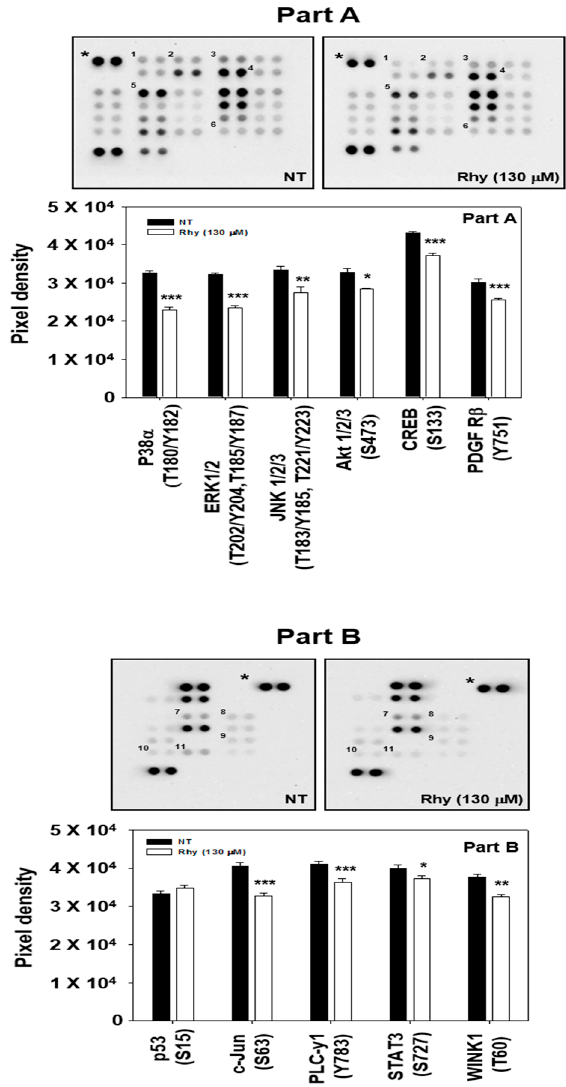
Figure 4. The Human Phospho-Kinase Array detects several phosphorylated proteins in Rhy-treated HepG2 cells. ( A , B ) HepG2 cells (1 × 10 7 cells/well) were incubated with Rhy (130 µM) for 12 h. Parts A and B of the array were each incubated with 330 µg of cell lysate. Arrays were performed according to the manufacturer’s protocols using Human Phospho-Kinase Array Kit (R&D Systems, Minneapolis, MN, USA), and array images are shown. Array profiles created by quantifying the mean spot pixel densities are shown. Graphs represent spot intensities of indicated proteins. Values represent the mean ± SD of triplicate cultures (*** p < 0.001, ** p < 0.01, * p < 0.05).